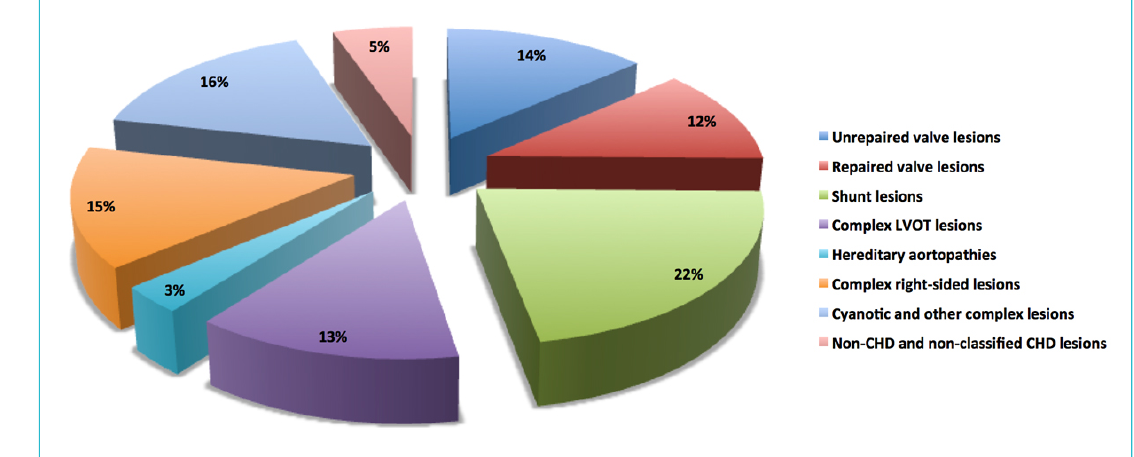
Figure 2: Distribution of lesions groups within SACHER. CHD = congenital heart disease; LVOT = left ventricular outflow